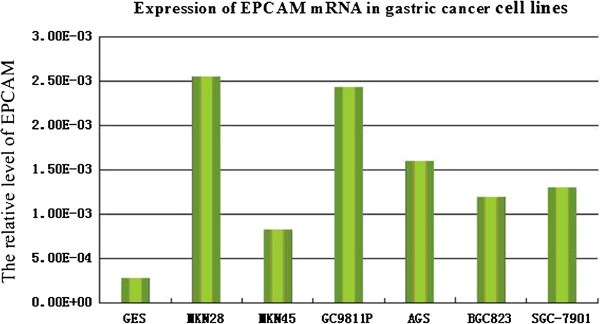
Expression of EPCAM mRNA in gastric cancer cell lines.